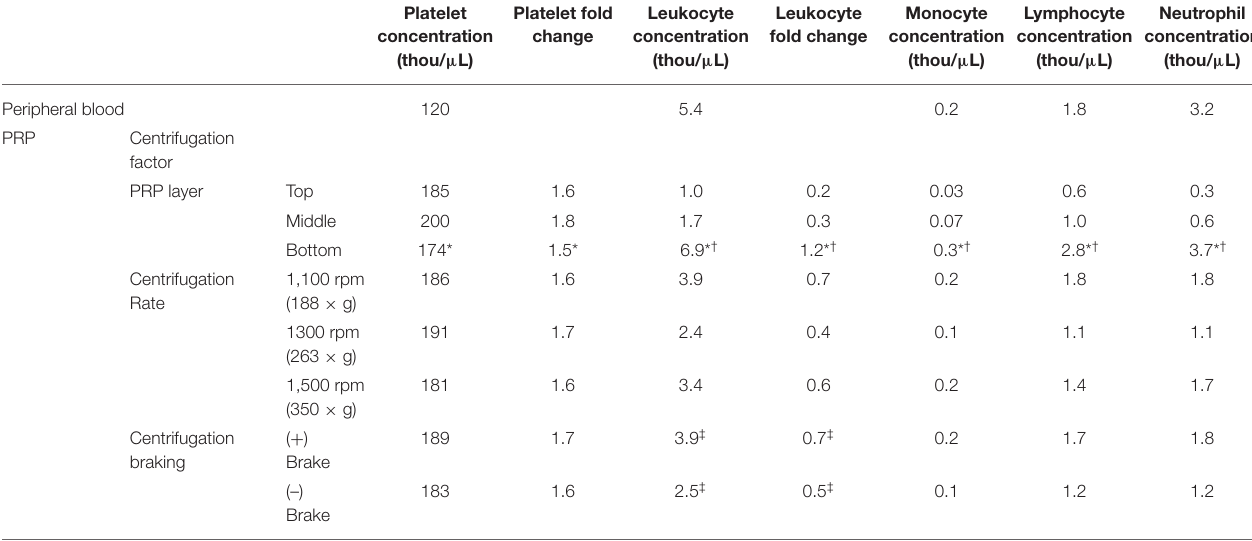
Platelet Platelet fold Leukocyte Leukocyte Monocyte Lymphocyte Neutrophil concentration change concentration fold change concentration concentration concentration (thou/ µ L) (thou/ µ L) (thou/ µ L) (thou/ µ L) (thou/ µ L)